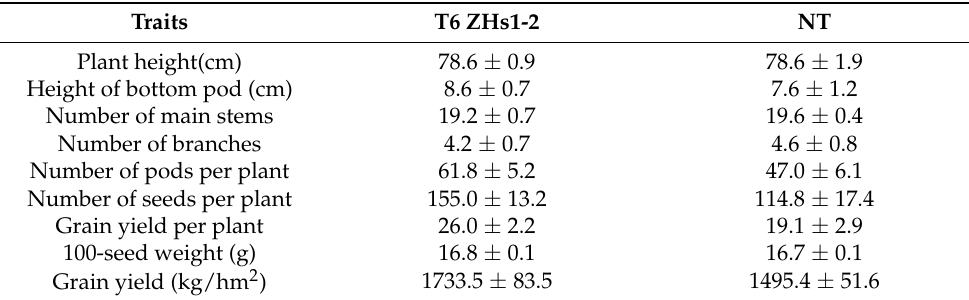
Table 4. Agronomic traits of T6 ZHs1-2 transformation event in the field.